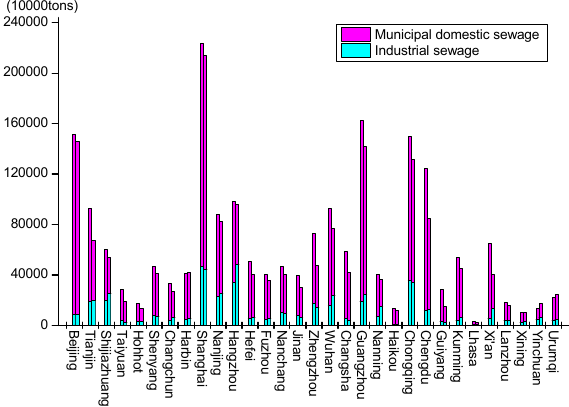
Figure 5. Comparison of sewage discharge between 2010 and 2018 from each provincial capital in China.